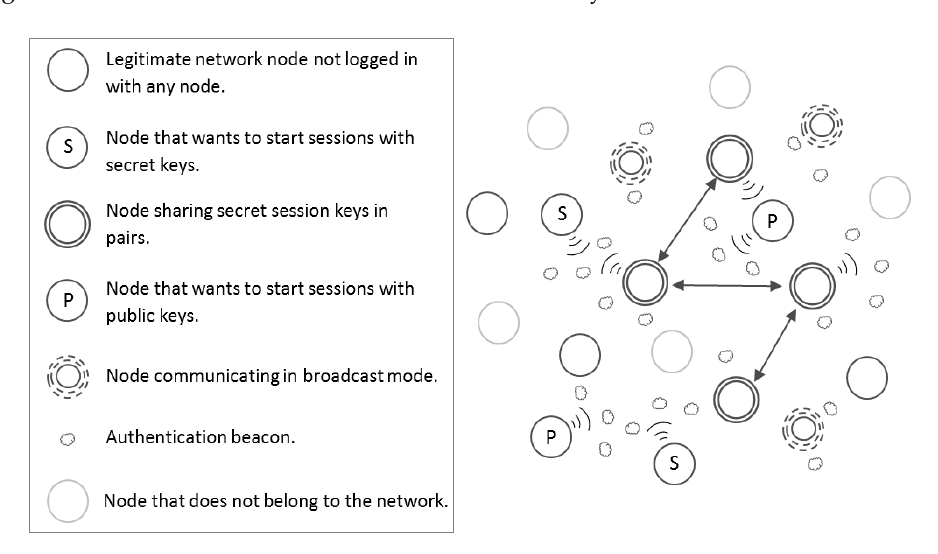
Figure 3. Types of MANET